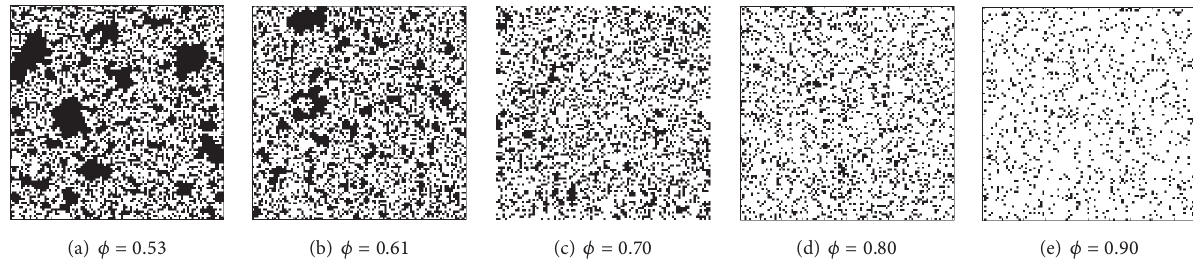
Figure 14: Various pore structures for randomly distributed squares geometry. Any fluid area isolated from flow path is converted to solid; thus 𝜙 is effective porosity of